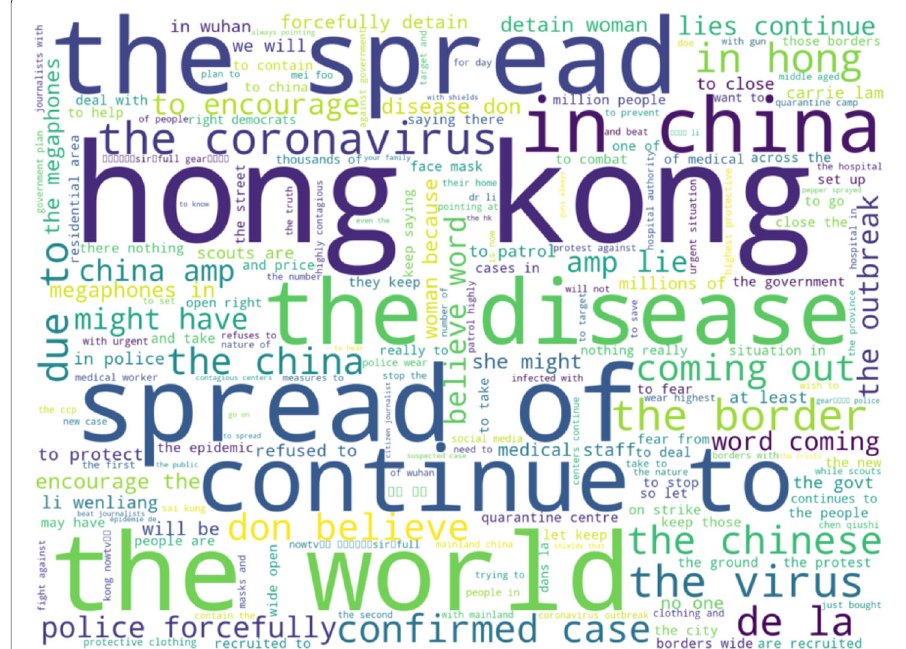
Fig. 11 Word map of frequently occurring words and phrases that co-occur with hashtags from the Chinese-focused cluster in the first period. There is a significant amount of verbiage about the spread of the virus and about protests in Hong